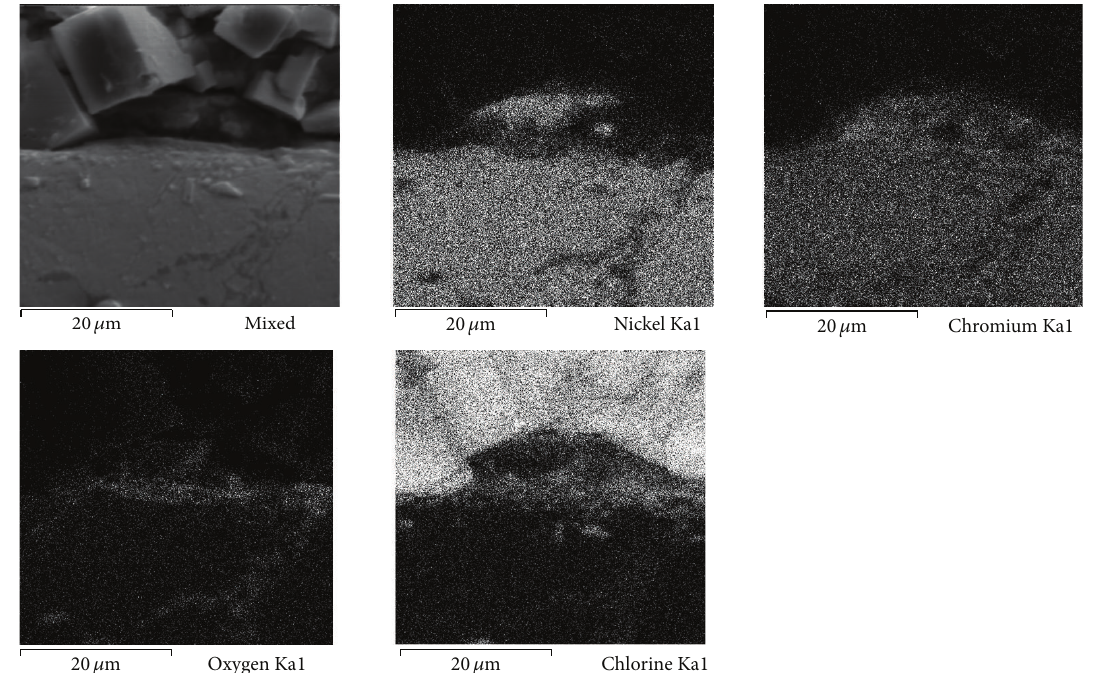
Figure 10: Cross-sectional aspect of the Ni20Cr as-grinded coating and elements distribution after corrosion test at 350 ∘ C.